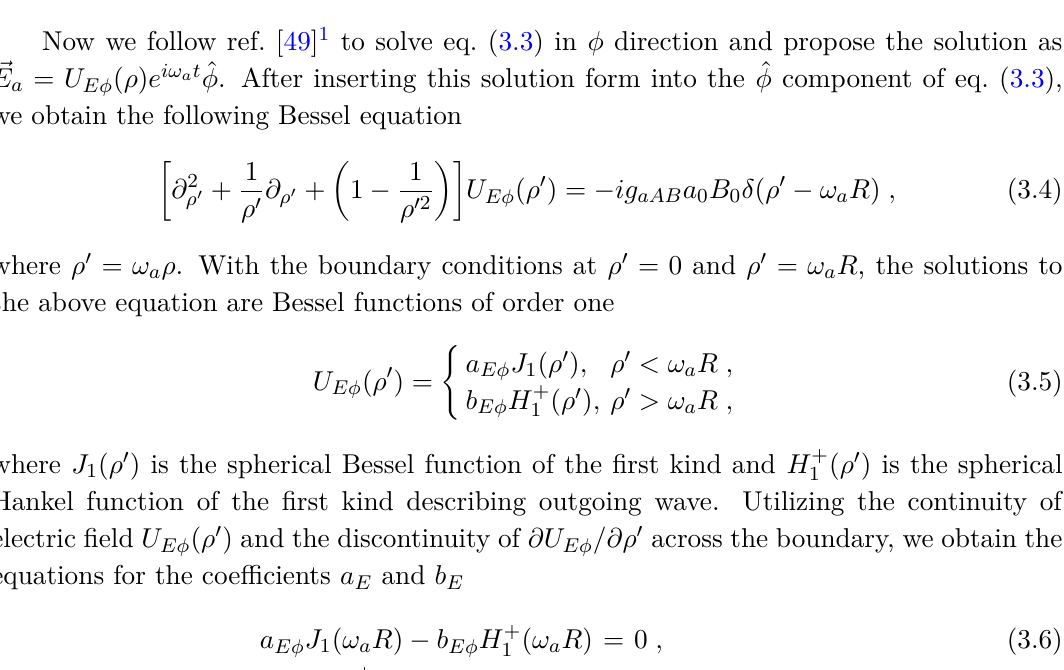
Figure 1 . The coordinates of axion ~v a and ~r